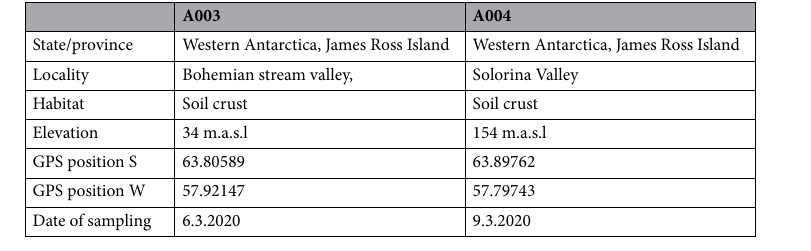
Table 2. Sampling